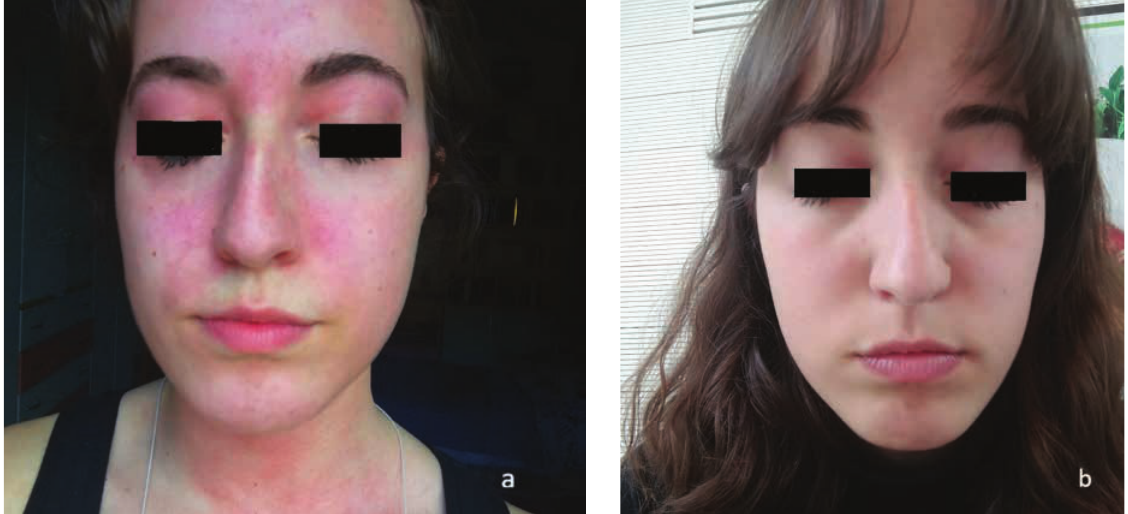
Figure 1: a) urticaria after solar exposure before omalizumab treatment and b) no reaction to solar exposure after omalizumab